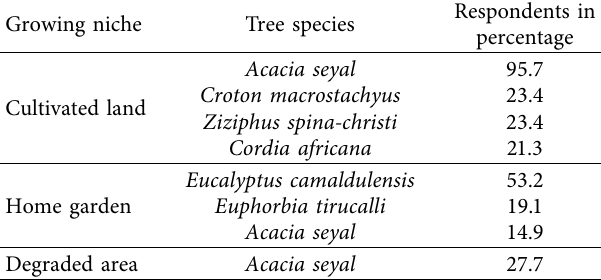
Table 6: List of dominant woody species and their growing niche in the